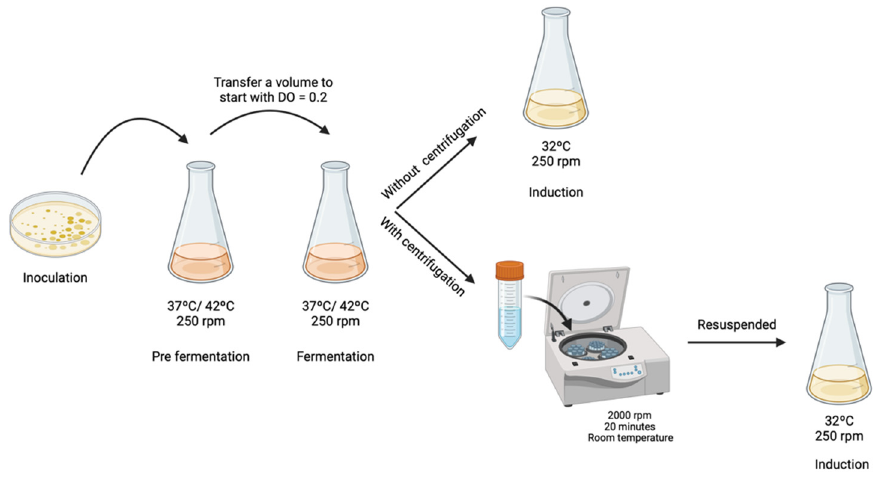
Figure 1. Schematic representation of different procedures to start the induction step.